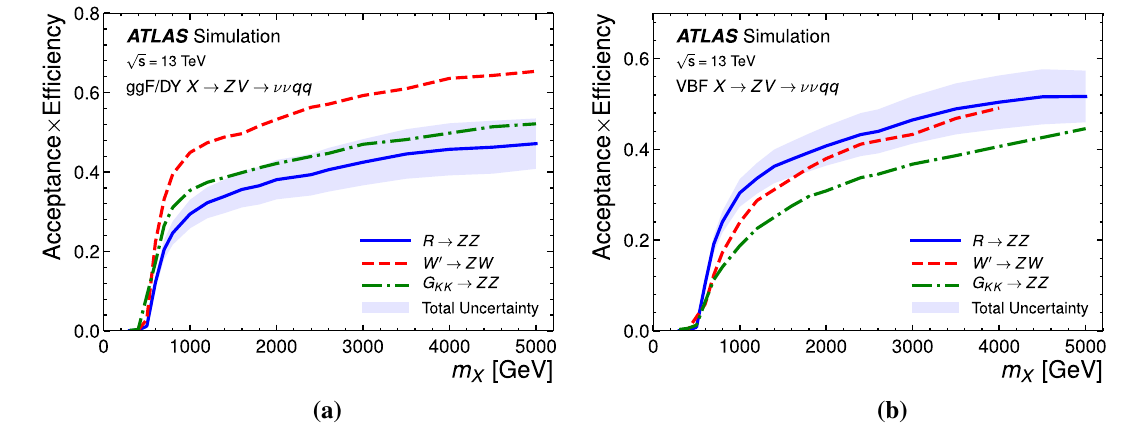
Fig. 6 Selection acceptance times efficiency for the X → ZV → νν qq signal events from MC simulations as a function of the resonance mass for a ggF/DY and b VBF production, combining HP and LP signal